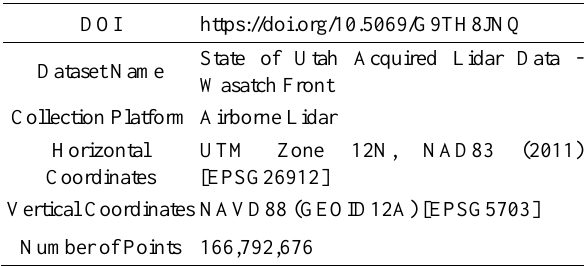
Table 2 Airborne LiDAR Data Profile